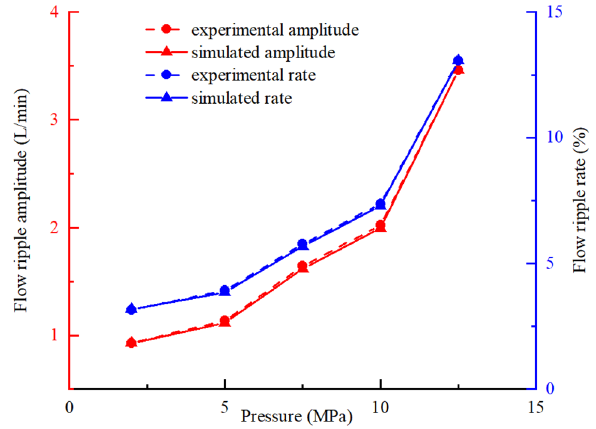
Figure 35. Influence of outlet pressure on flow ripple characteristics ( n = 1200 r/min).